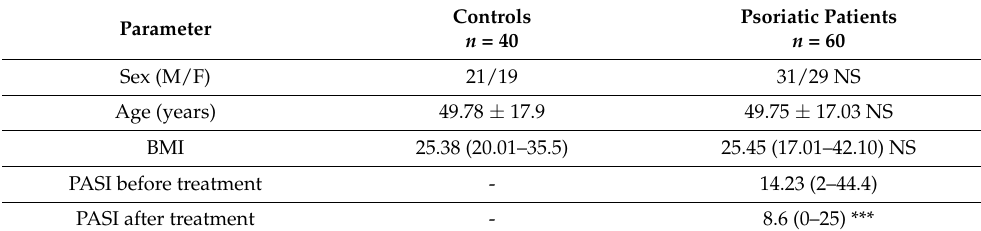
Table 1. Baseline characteristics and comparison of patients and controls.